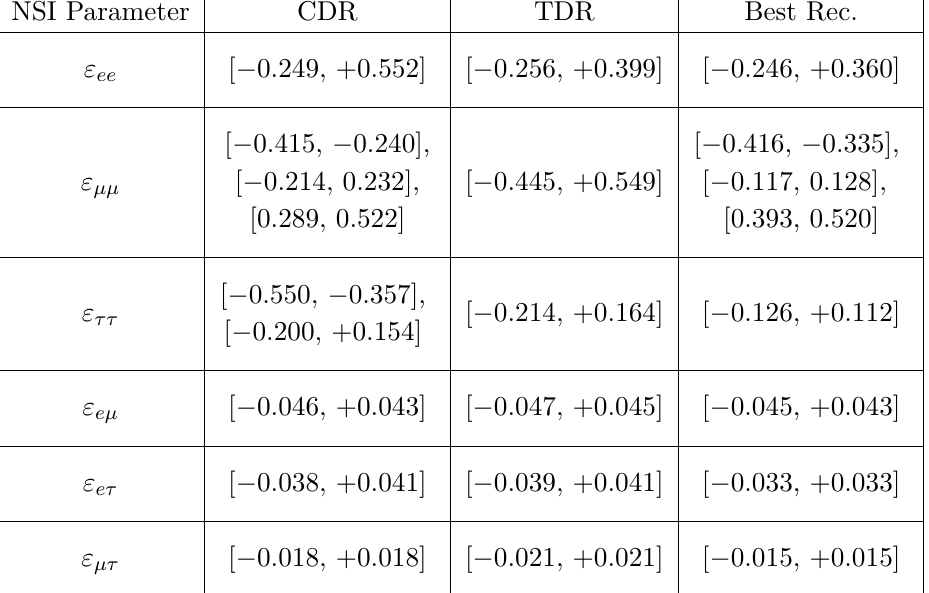
Table 1 . DUNE sensitivities on the NSI parameters at 2 σ confidence level (C.L.) with 1 degree of freedom (d.o.f.) (i.e. ∆ χ 2 = 4 ), assuming normal mass ordering and δ CP (true) = − 90 ◦ (cf. figure 3). Left, middle, and right columns correspond to CDR, TDR, and Best Reconstruction cases respectively. Here the non-diagonal NSI parameters have been assumed